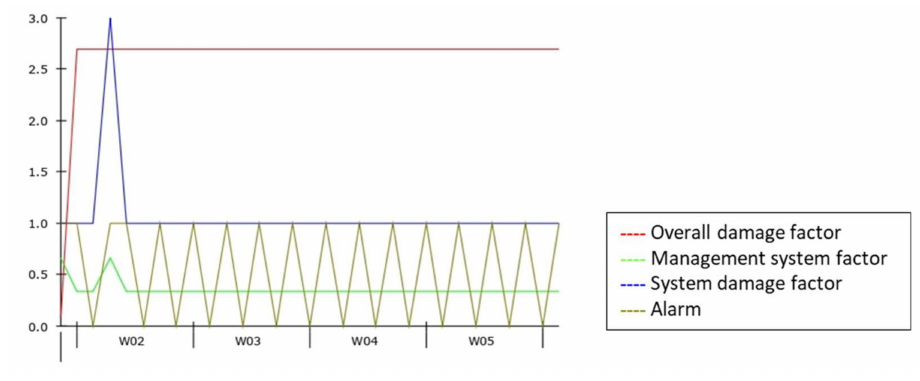
Figure 15. Management